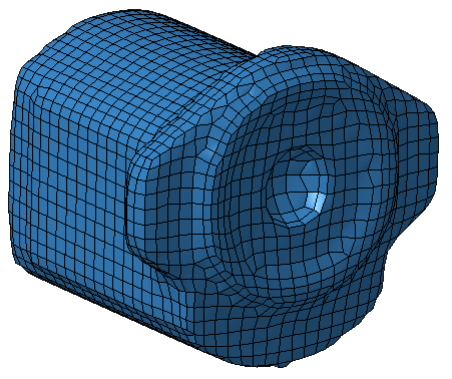
Figure 15. Boundary element surface mesh.